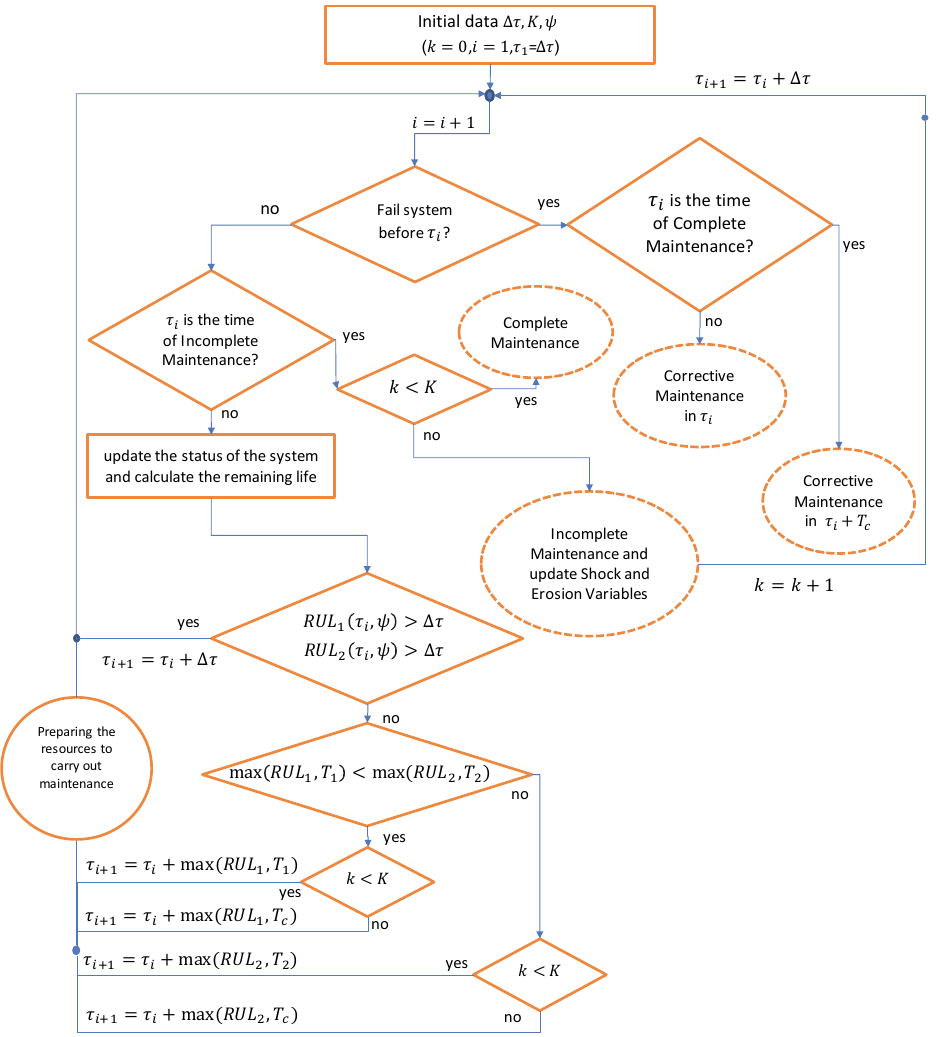
Fig. 4 . Maintenance decision-making